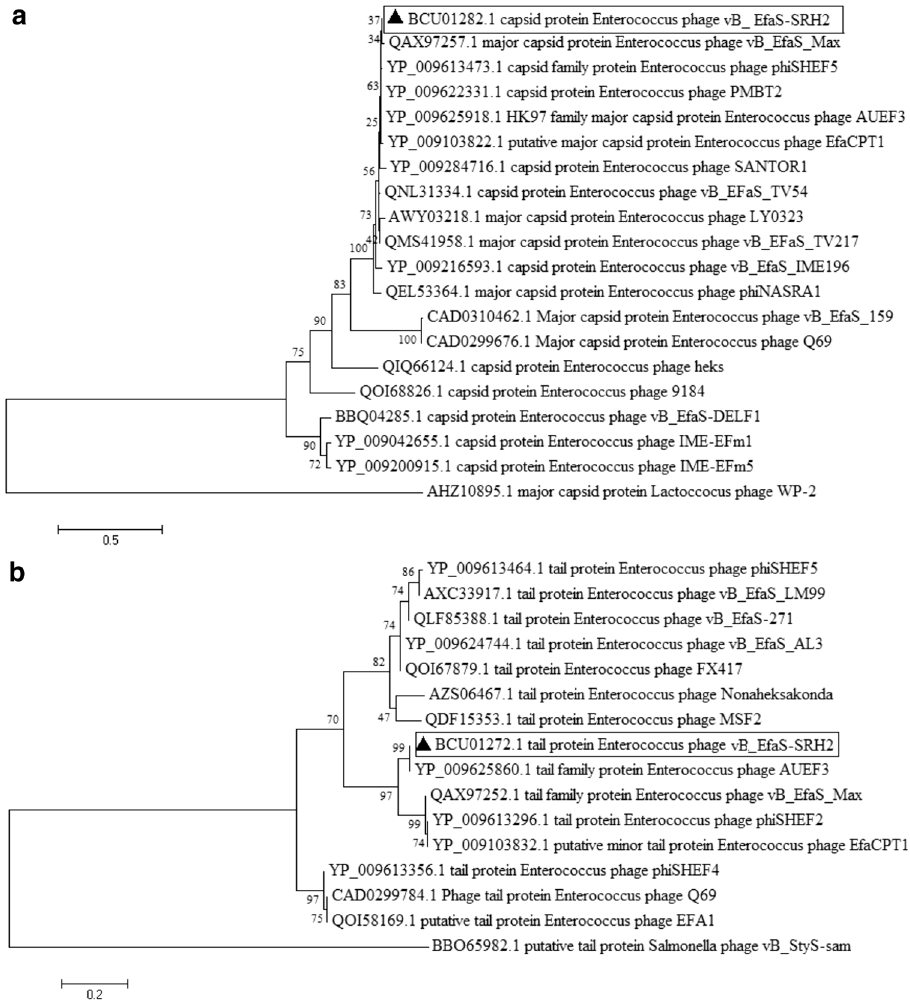
Figure 11. ( a , b ) Phylogenetic relationship of vB_EfaS-SRH2 phage. Phylogenetic trees drawn based on amino acid sequences of the capsid protein ( a ) and tail family protein ( b ) with MEGA 7 software with 1000 bootstrap replications. ▲ : sequences of the phage detected in this study.